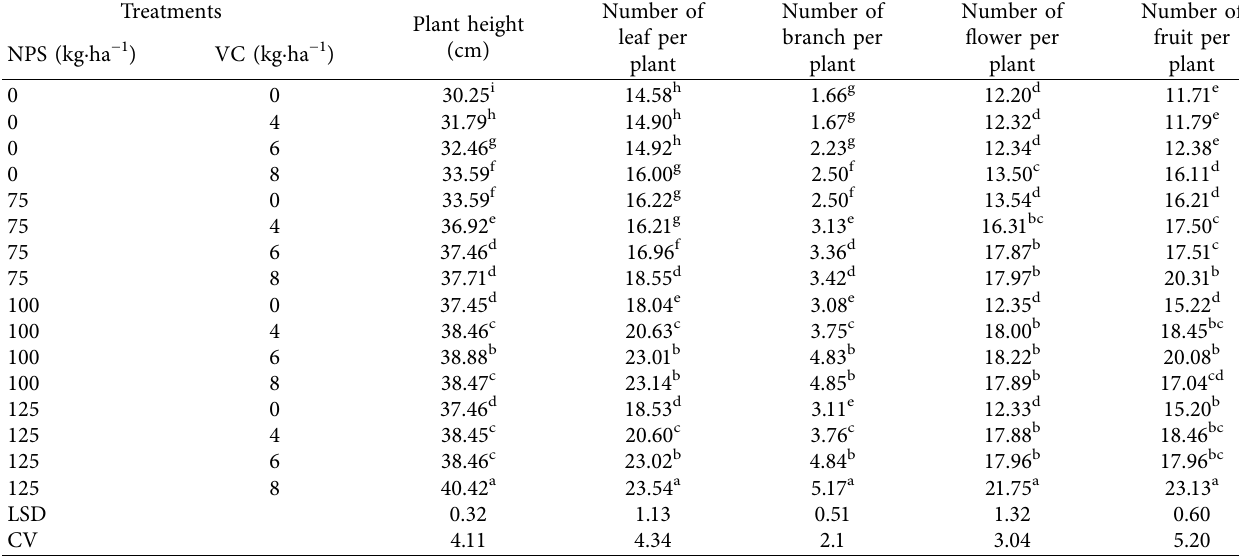
Table 4: Te over years (2021 and 2022) mean value of the studied parameters under the efects of NPSB and vermicompost fertilizers rates.